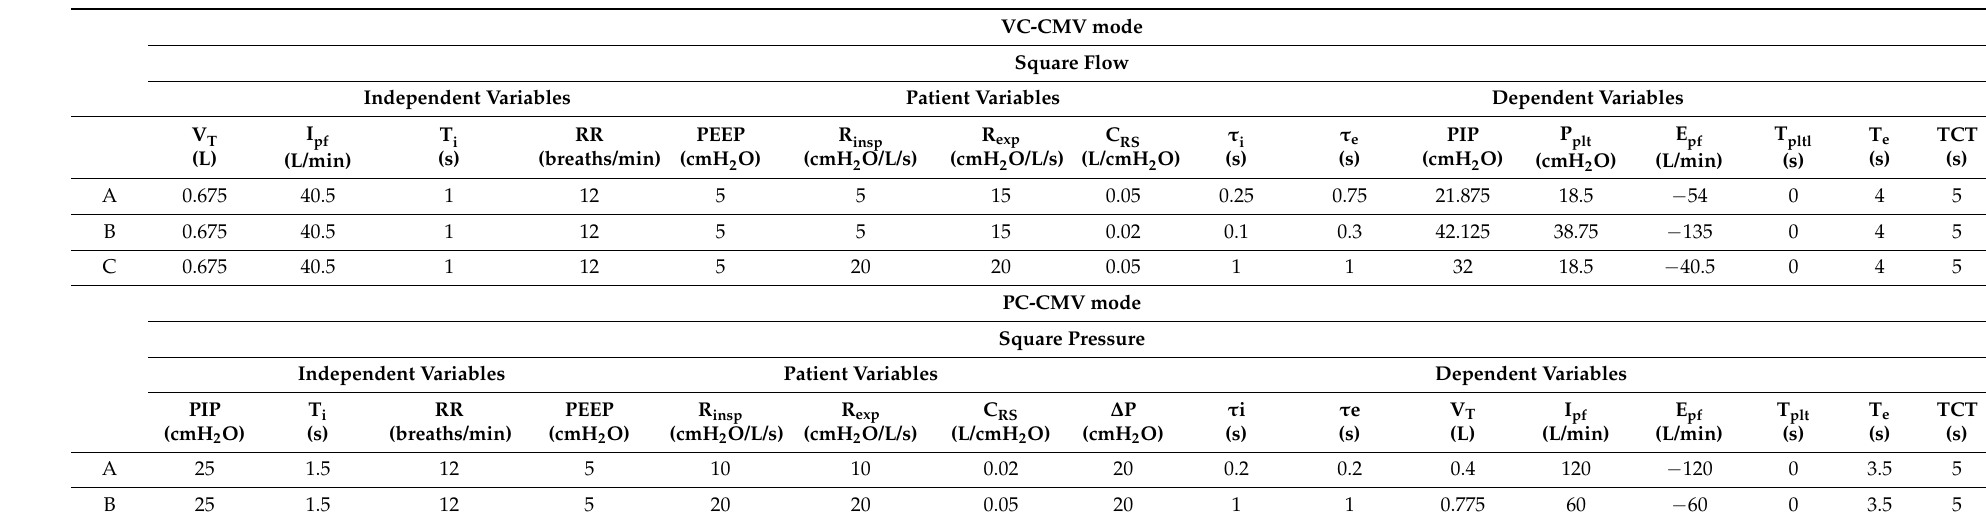
Table 9. Independent, dependent, and patient variables of the real-life trends of the Case